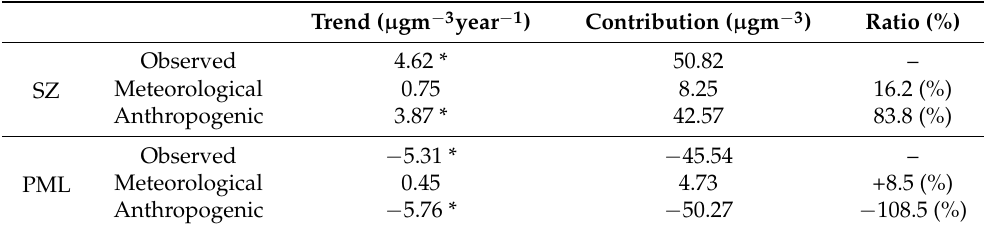
Table 4. Contribution of meteorological and anthropogenic factors to ozone